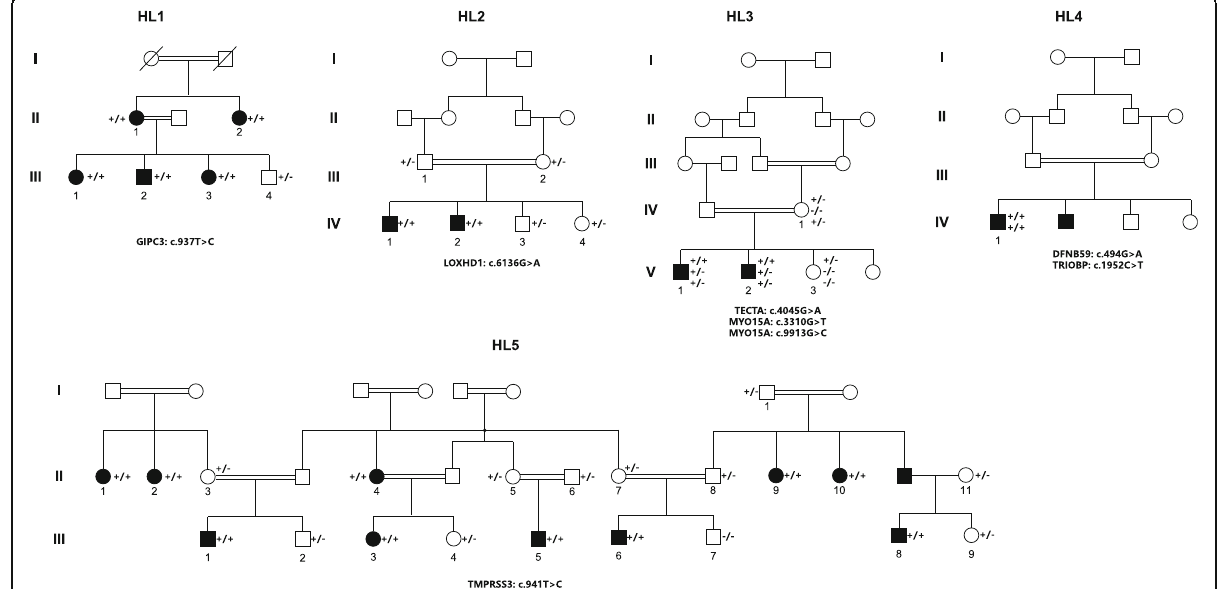
Fig. 1 Pedigree figures of the five consanguineous families with genotypes of available individuals. The squares and the circles represent males and females, respectively. The black-filled symbols indicate patients with hearing loss, and a symbol with a diagonal line indicates a deceased family member. The symbols with numbers indicate the availability of the individual ’ s DNA. The candidate variants are listed under each pedigree, and the genotypes of the individuals for the variants are marked. “ +/+ ” indicates homozygous variant, “ +/ − ” indicates heterozygous variant, and “ − / − ” indicates